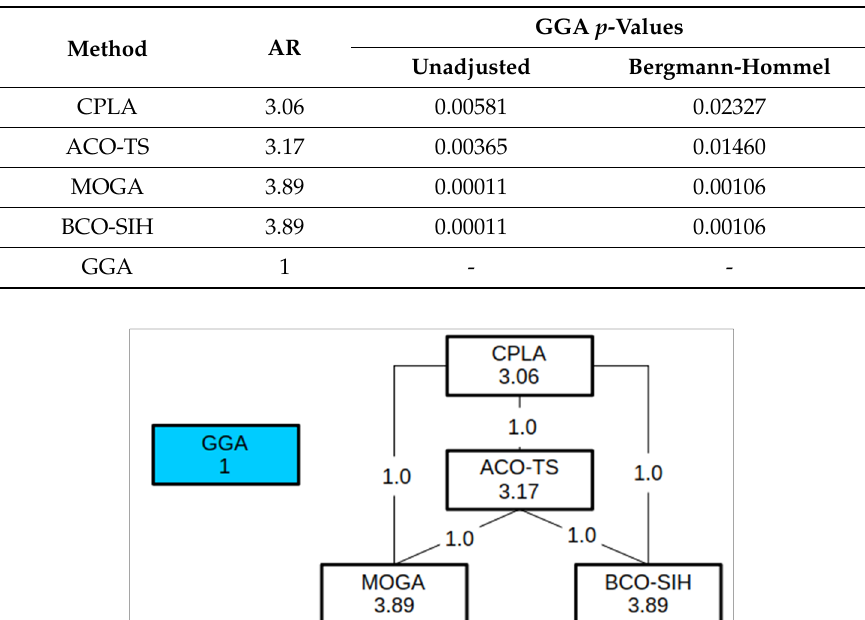
Table 8. p -values for multiple comparisons among methods.